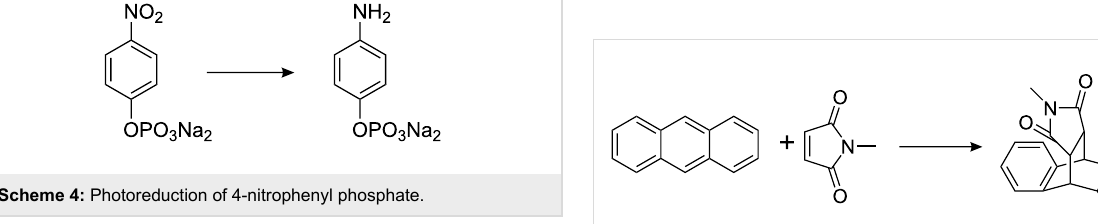
Scheme 5: Photo Diels–Alder-reaction of anthracene with N-methyl- maleinimide.